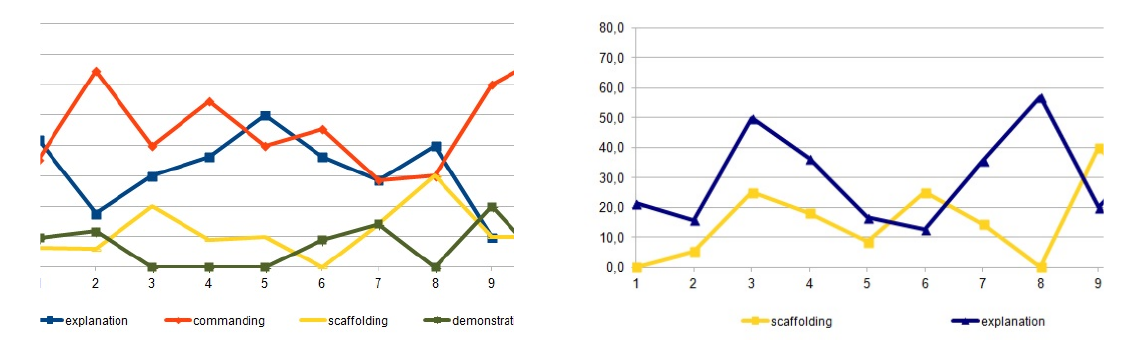
Figure 6. The most frequently used techniques of a tutor instructing a beginner in the first and second part of the